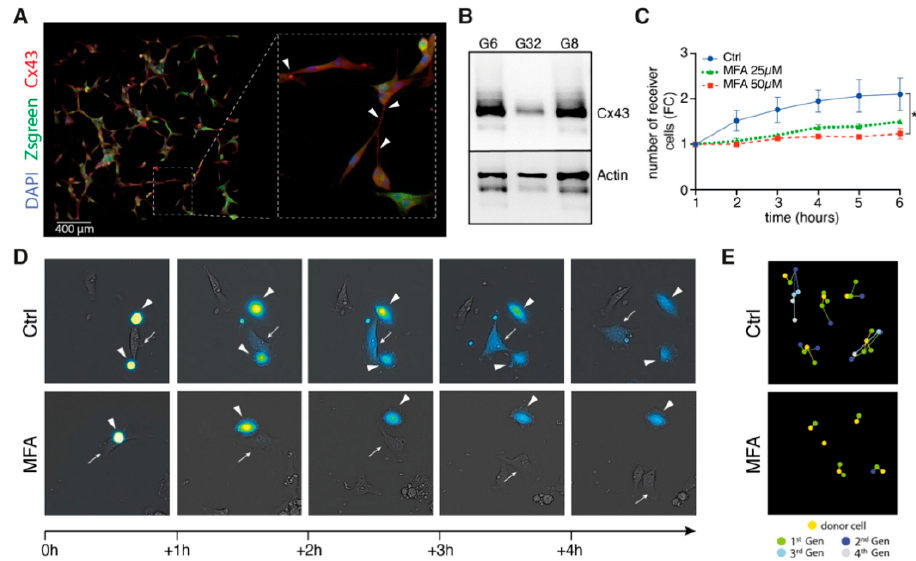
Figure 2. Meclofenamate blocks gap junction-mediated intercellular cytosolic traffic. ( A ) Representative fluorescence image of Cx43 expression for G8 primary glioblastoma cell population. White arrowheads point to Cx43 expression along the membrane protrusions. ( B ) Verification of Cx43 expression using Western Blot analysis. ( C ) Quantification of receiver cells that have incorporated the calcein dye that is transferred through cells connected by gap junctions for the G8 cell population. Data is given as mean ± SEM. P-values are determined by Wilcoxon matched-pairs signed rank test. * denotes p<0.05. ( D ) Representative fluorescence images acquired by the IncuCyte ® S3 Live-Cell Analysis System illustrating the transfer of the calcein dye from donor cells (arrowheads) to (potential) receiver cells (arrows). ( E ) Graphical illustration of dye spreading from one donor cell to multiple generations of receiver cells. Cx43, connexin-43; FC, fold change; Gen, generation; MFA, meclofenamate.